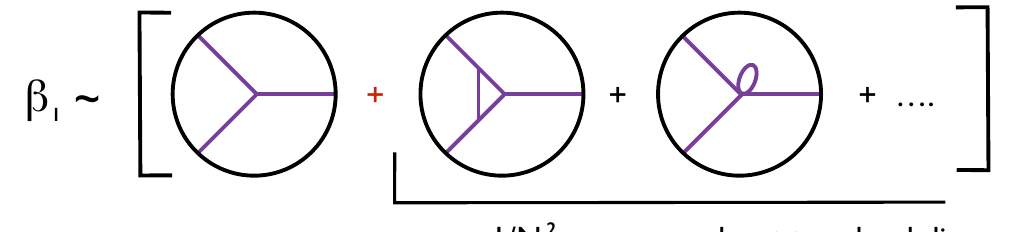
Figure 4. Witten diagrams contributing to C OOO . Violet lines correspond to propagation of (cid:30) (cid:12)elds and may have spacetime derivatives acting on them, depending on the speci(cid:12)c structure of the operators (3.2). At tree-level, only cubic couplings can contribute to the three-point function. At loop level, also couplings with n > 3 can contribute, e.g., the quintic coupling shown in the (cid:12)gure.